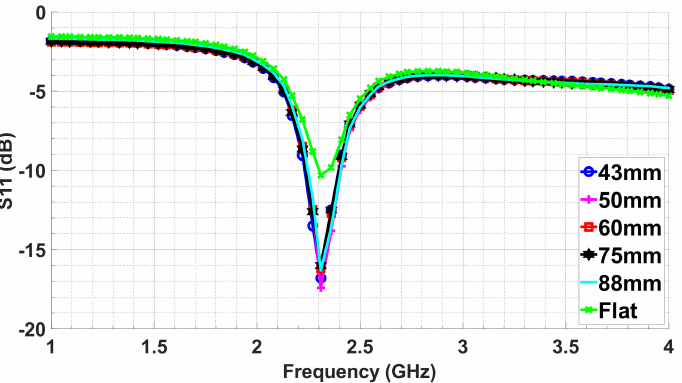
Figure 11. Comparison between measured input reflection coefficients ( S 11 ) of the 3D-printed Electrifi antenna prototype on a flat surface and cylindrical curved surfaces of 43, 50, 60, 75, and 88 mm,